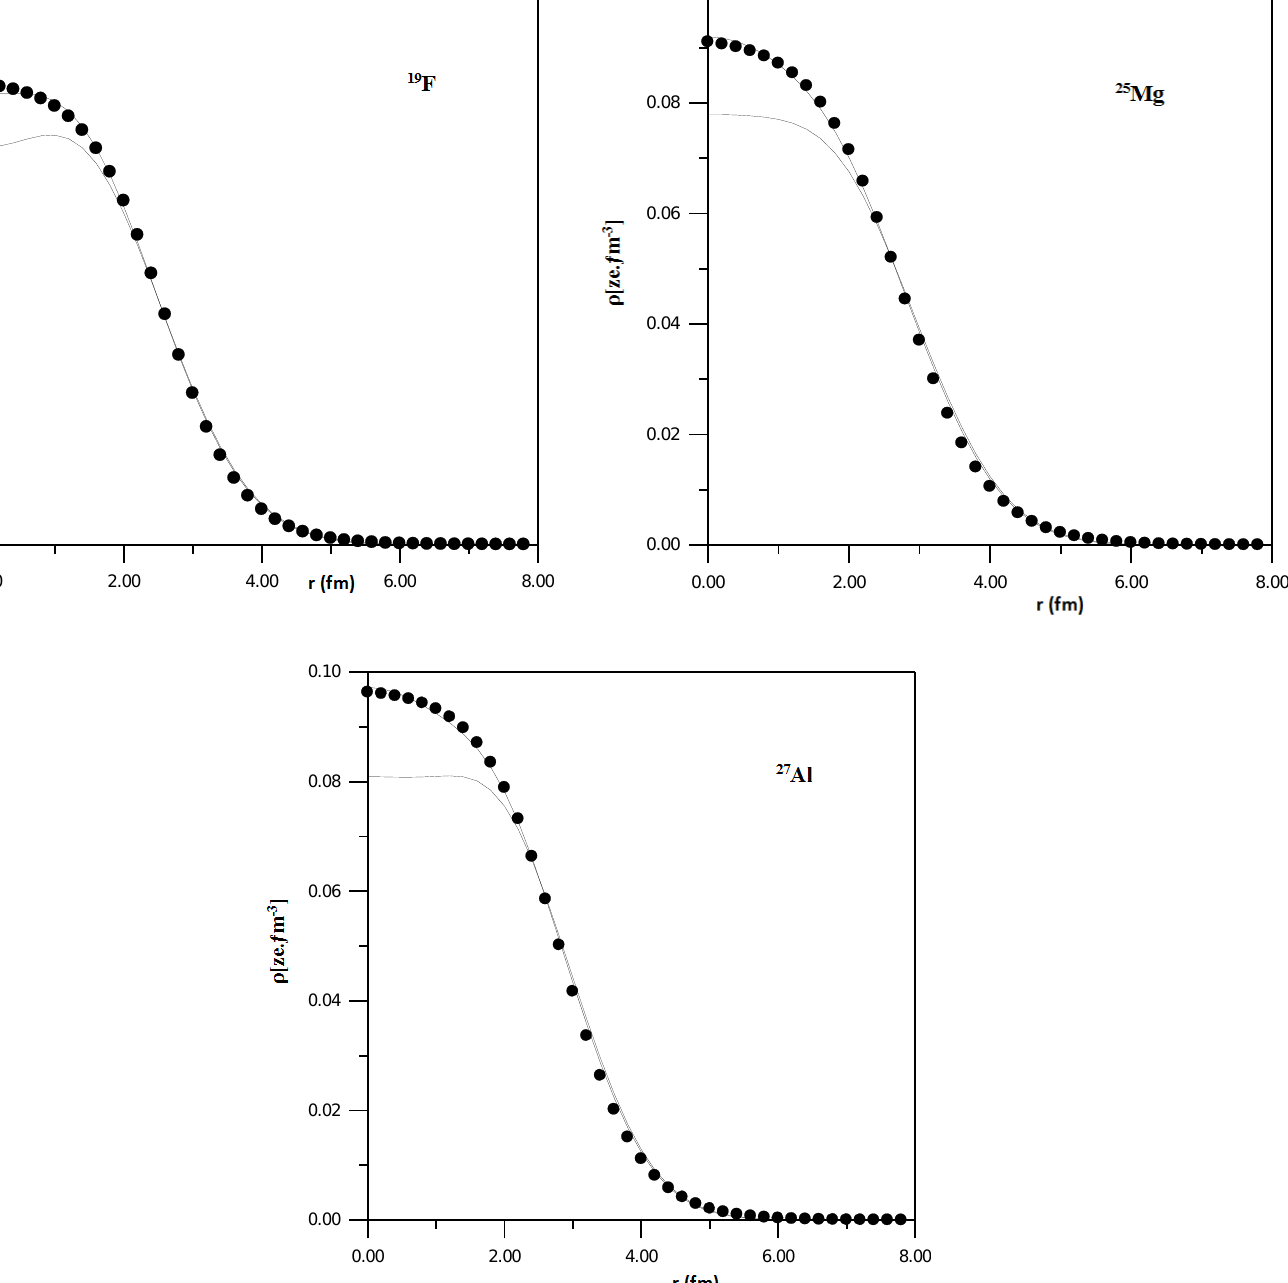
Fig.1: Dependence of the 2BCDD on r (fm) for 19 F, 25 Mg and 27 Al nuclei. The dotted symbols are the experimental data of Ref